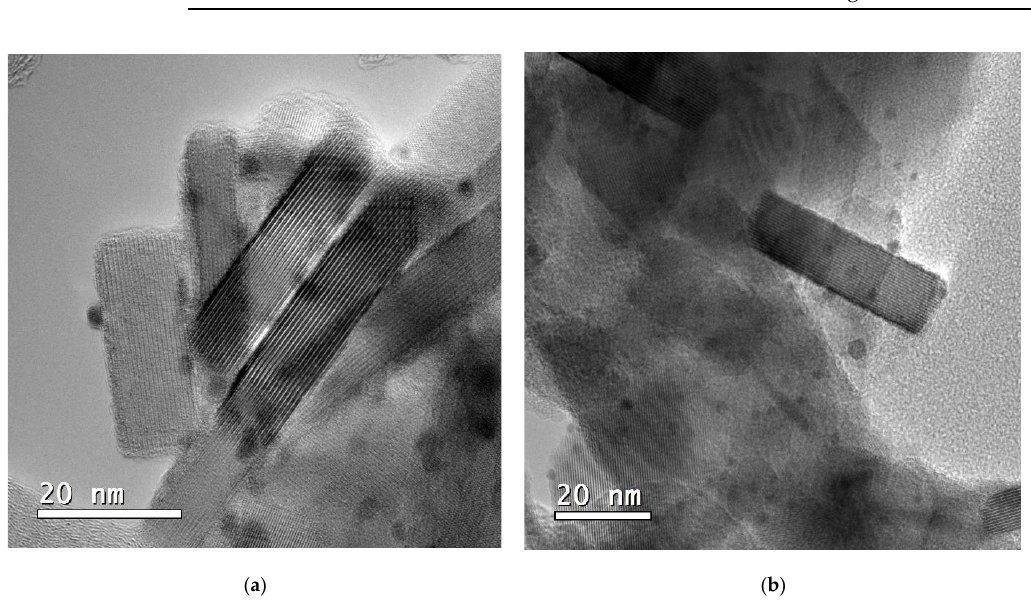
Figure 3. HR-TEM images obtained for 1 % Ag/TiO 2 /C ( a ) and 1% Pt/TiO 2 /C ( b ).